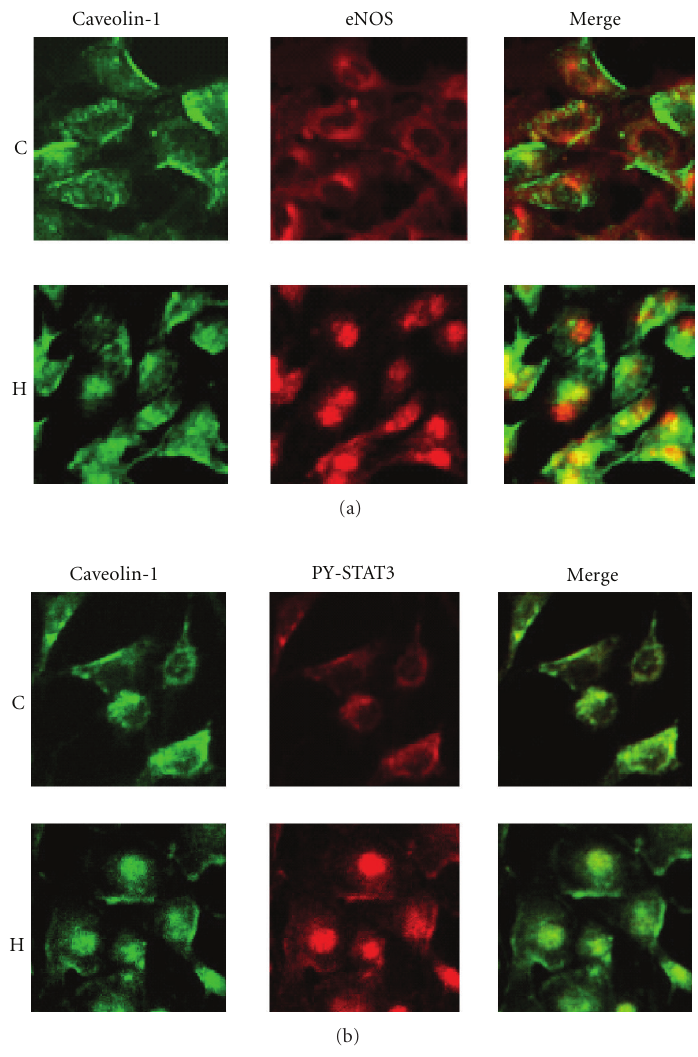
Figure 1: Bovine pulmonary artery endothelial cells (BPAEC) after 24hr exposure to hypoxia (H, 5% O 2 ) and in normoxia (C). (a) During hypoxia the expression of caveolin-1 (green) and eNOS (red) appear increased and they form a complex. (b) PY-STAT3 (red) activation is observed after exposure to